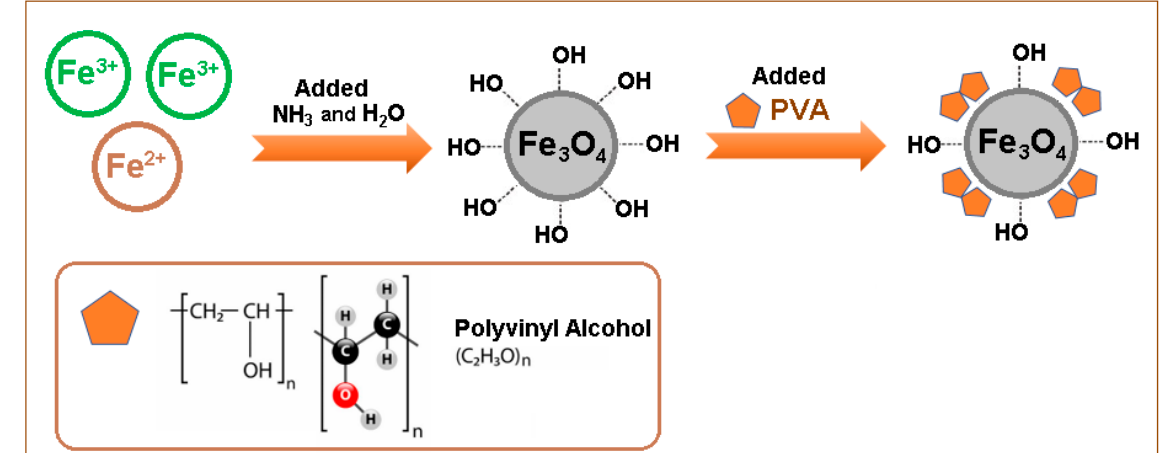
Figure 1. Schematic representation of the preparation of Fe 3 O 4 /PVA (modified composite).